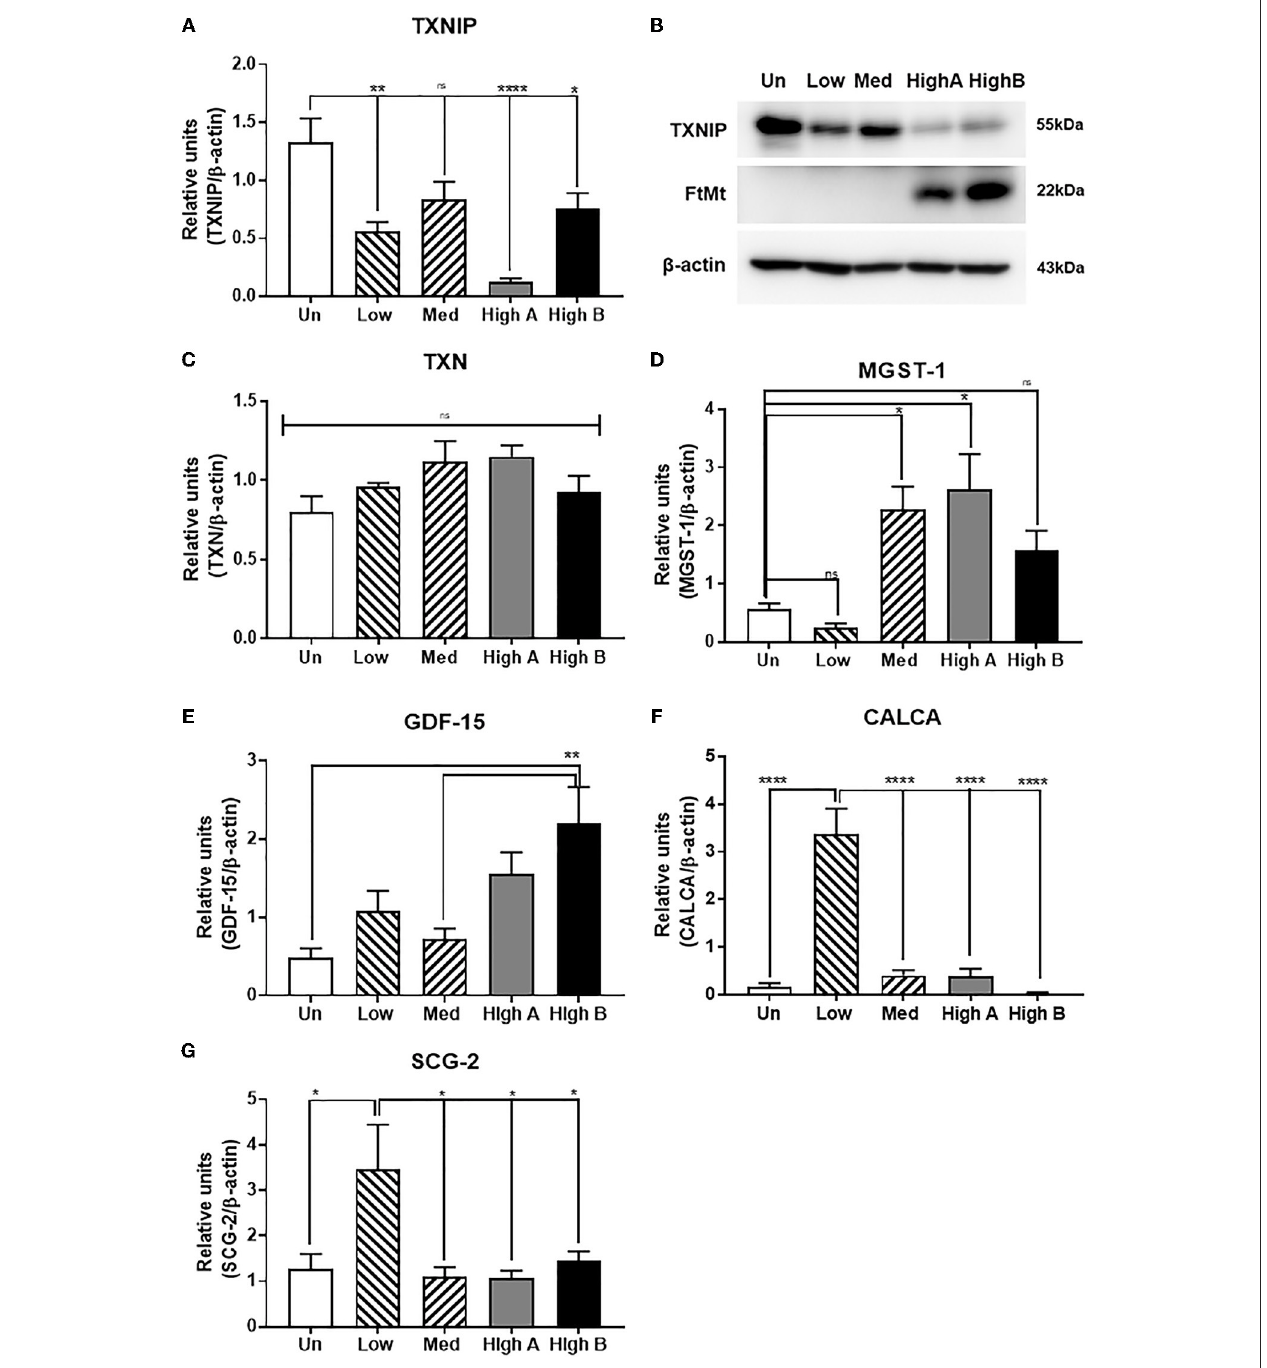
FIGURE 7 | Validation of expression of key differentially expressed genes identified by microarray. (A) Real time PCR measurement of expression of thioredoxin-interacting protein (TXNIP) in different clones. Results are combined of three independent experiments. Data analyzed by one-way ANOVA with Tukey’s post-hoc test of significance. Results indicate level of significance. * p < 0.05; ** p < 0.01, *** p < 0.001, **** p < 0.0001. (B) Western blot showing relative levels of TXNIP protein in different clones compared to expression of FtMt and β -actin. ns: not significantly different (C) Real time PCR measurement of expression of thioredoxin (TXN) in different clones. Results are combined of three independent experiments. Data show no significant differences between expression levels of different clones. (D) Real time PCR measurement of expression of microsomal glutathione transferase (MGST) − 1 in different clones. Results are combined of three independent experiments. Data analyzed by one-way